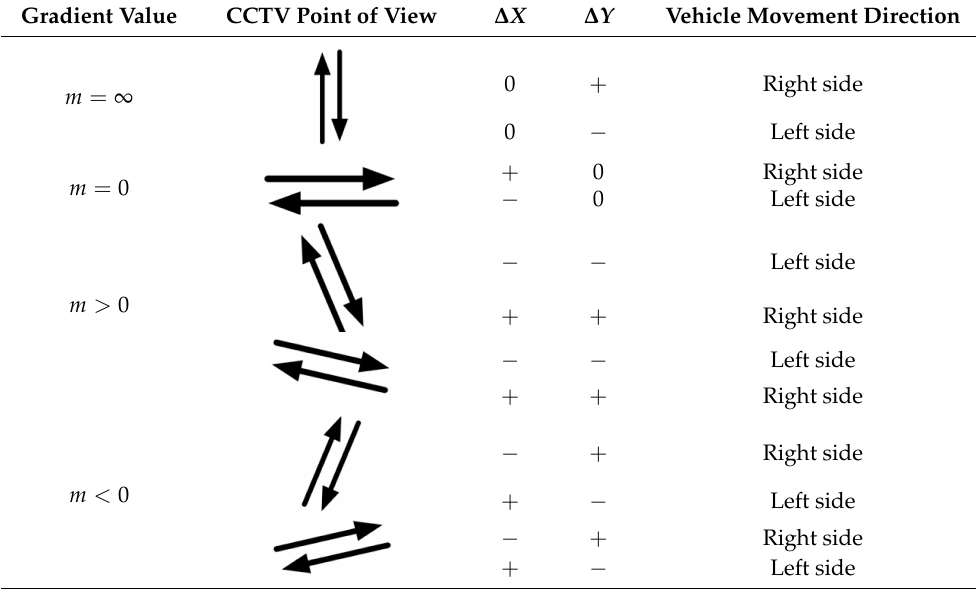
Table 4. The calculation of vehicle direction based on movement gradient.